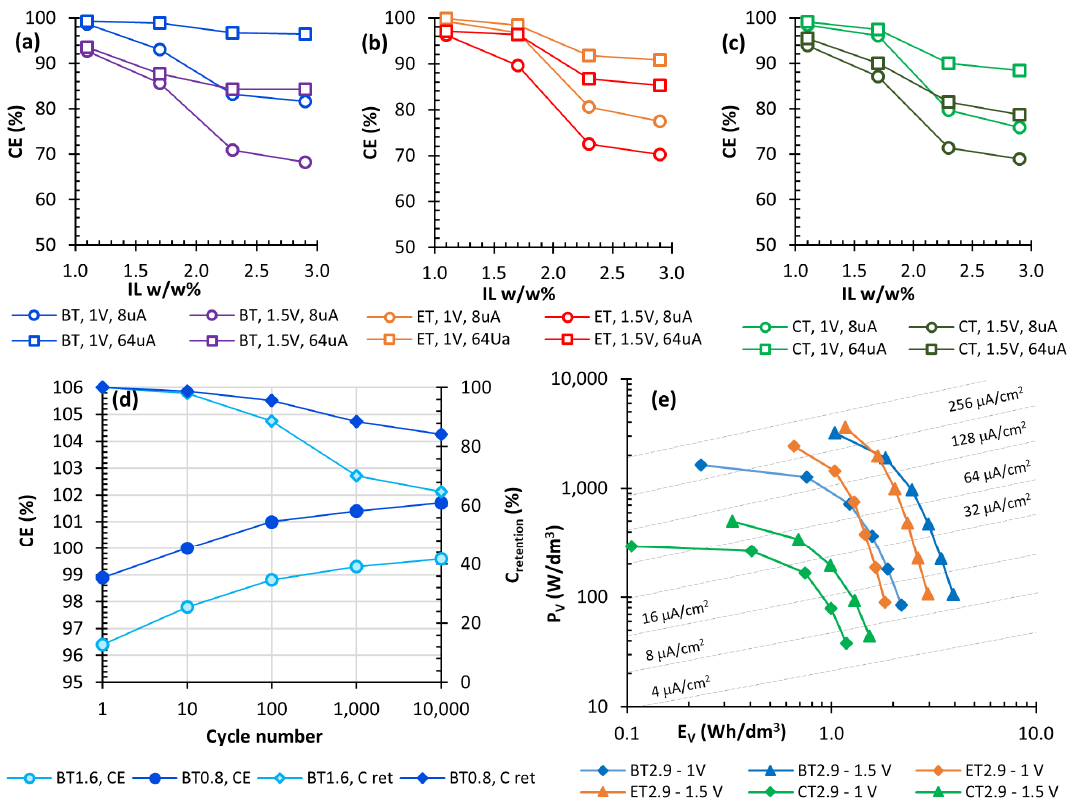
Figure 7. ( a – c ) CE values extracted from GCD curves with ∆ V max = 1.0 and 1.5 V and i A = 8 and 64 µ A / cm 2 as function of IL concentration; ( d ) CE and C retention values tested under 1 × 10 4 working cycles ( ∆ V max = 1.0 V and i A = 64 µ A / cm 2 ); ( e ) Ragone plot reporting the volumetric energy E V and the average delivery power P V obtained from the samples with the higher loading of ionic liquid (BT2.9, ET2.9, CT2.9). All measurements have been taken in air environment.